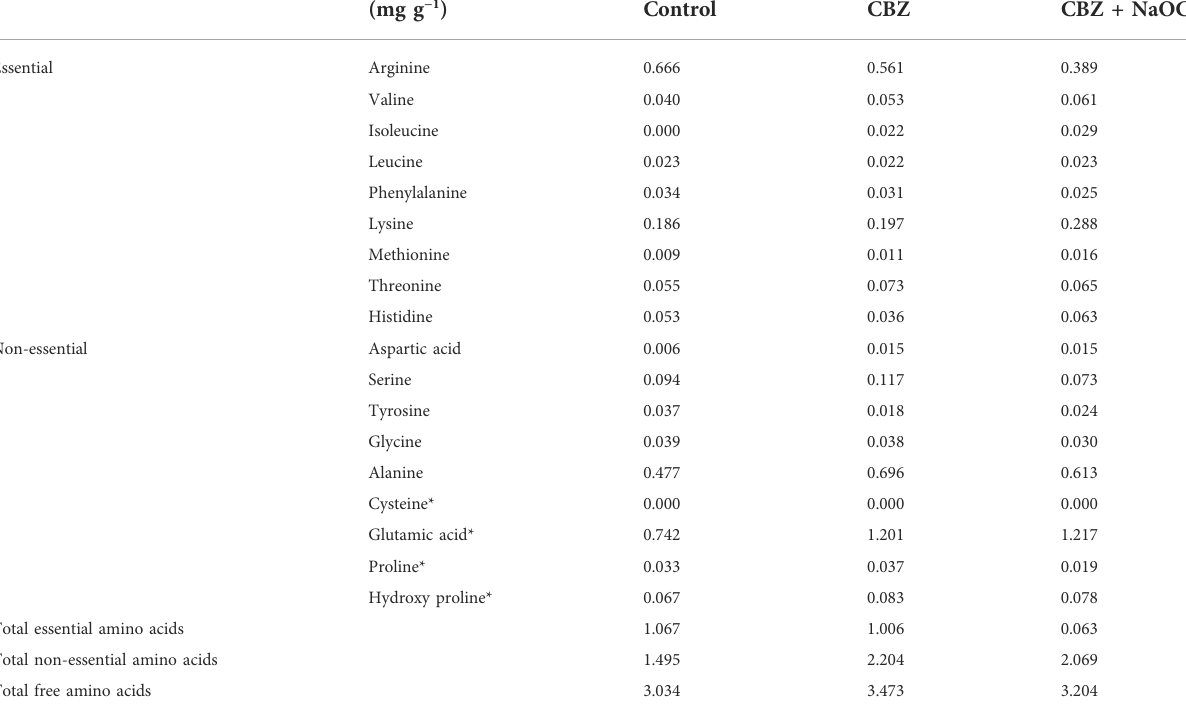
TABLE 3 Free amino acid contents of microalgal biomass with CBZ and NaOCl